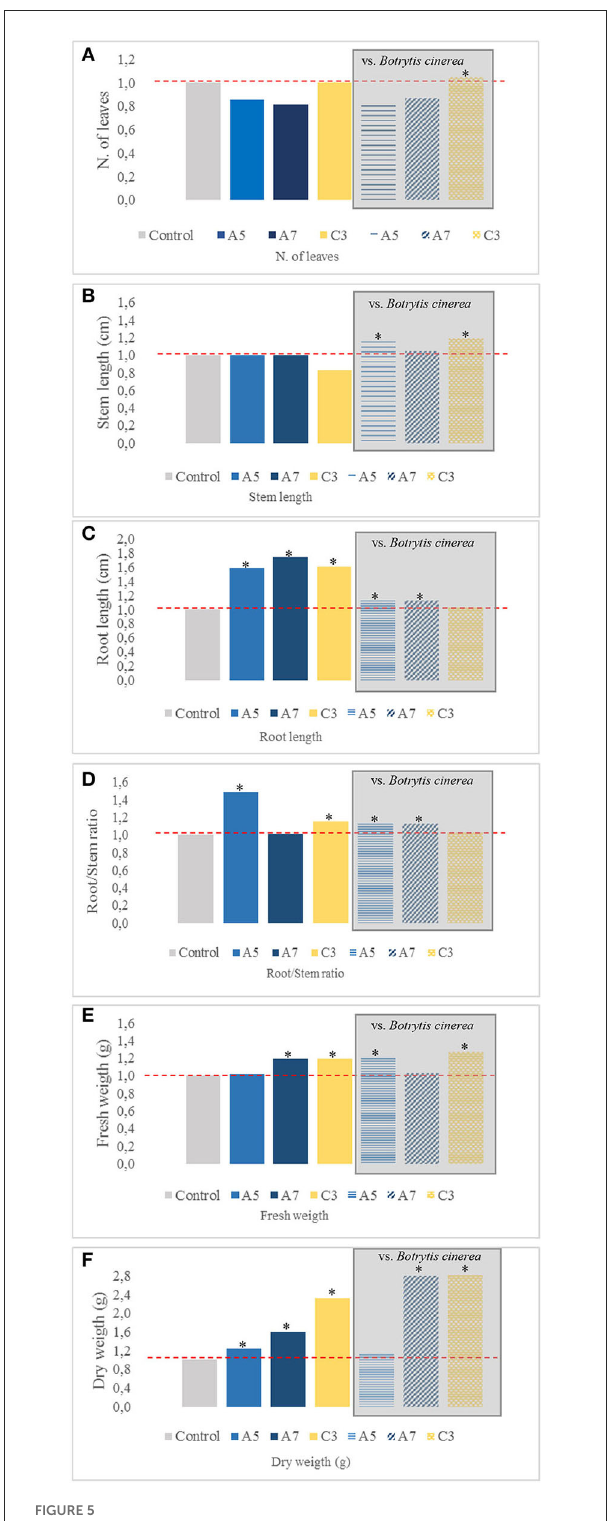
FIGURE5 Measurement of the increase with respect to the control of plant growth promoting effect by biopriming application of the three microbial formulations selected: strains A5, and A7, and Consortium-3 (C3: A5 + A7). Before (bars with color fill) and after the inoculation with Botrytis cinerea . (A) Number of leaves; (B) Stem length (cm); (C) Root length (cm); (D) Root/Stem ratio; (E) Fresh weight (g); and (F) Dry weight (g). Asterisks show different homogeneous groups with statistically significant differences (Fisher’s LSD test, P <